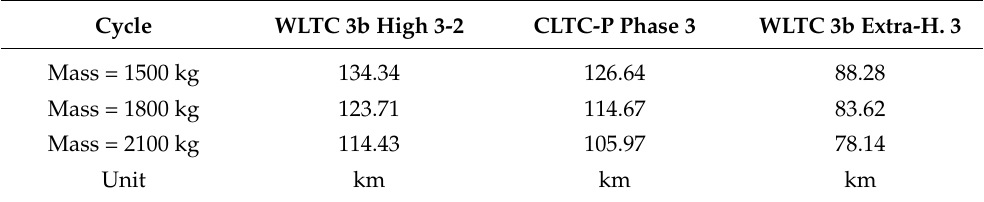
variants of vehicle mass.